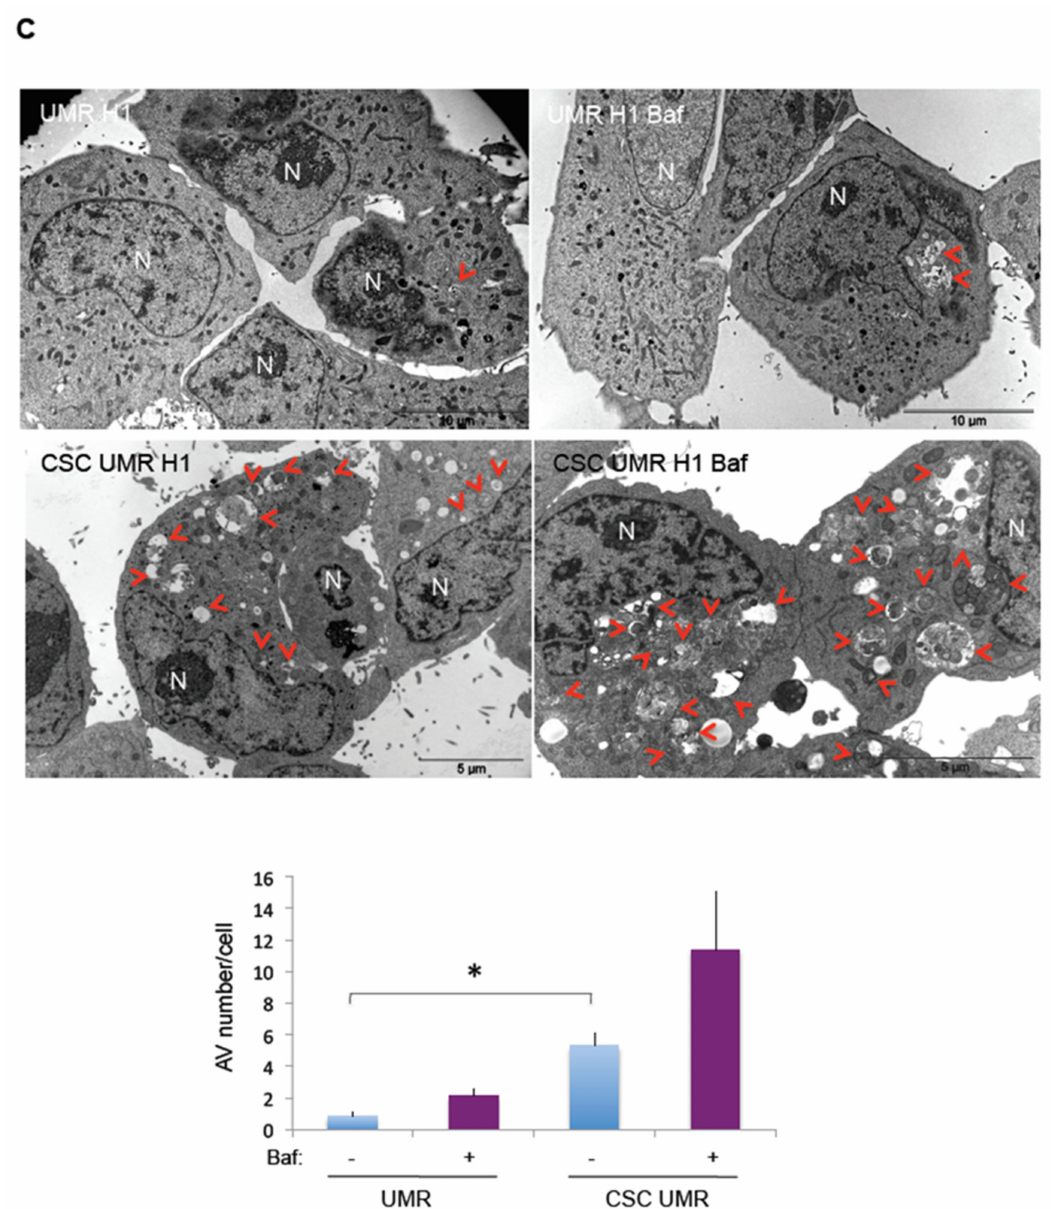
Figure 4. Comparison of basal and stress-induced autophagy in CSC UMR-enriched population and UMR parental cells. ( A , B ) LC3-II expression was analyzed by Western blot in the UMR cell line and in the corresponding CSC-enriched population, in complete medium ( C ) and at 1 (H1), 4 (H4) and 16 (H16) hours after HBSS incubation. One hour prior to protein extraction, Baf was added ( + ) or not ( − ) to block the autophagic flux. LC3-II to β -actin relative expression levels are presented. The results are normalized relative to the control in the absence of Baf. Histograms represent the mean ± SEM of three independent experiments. The dashed line points to the LC3-II level in the control condition ( C ) TEM analysis of the UMR cell line and the corresponding CSC-enriched population after 1 h of HBSS treatment (H1). Histograms represent the mean ± SEM of the number of autophagic vesicles (AV) per cell. Red arrowhead: autophagic vesicle. N: nucleus. *: p <